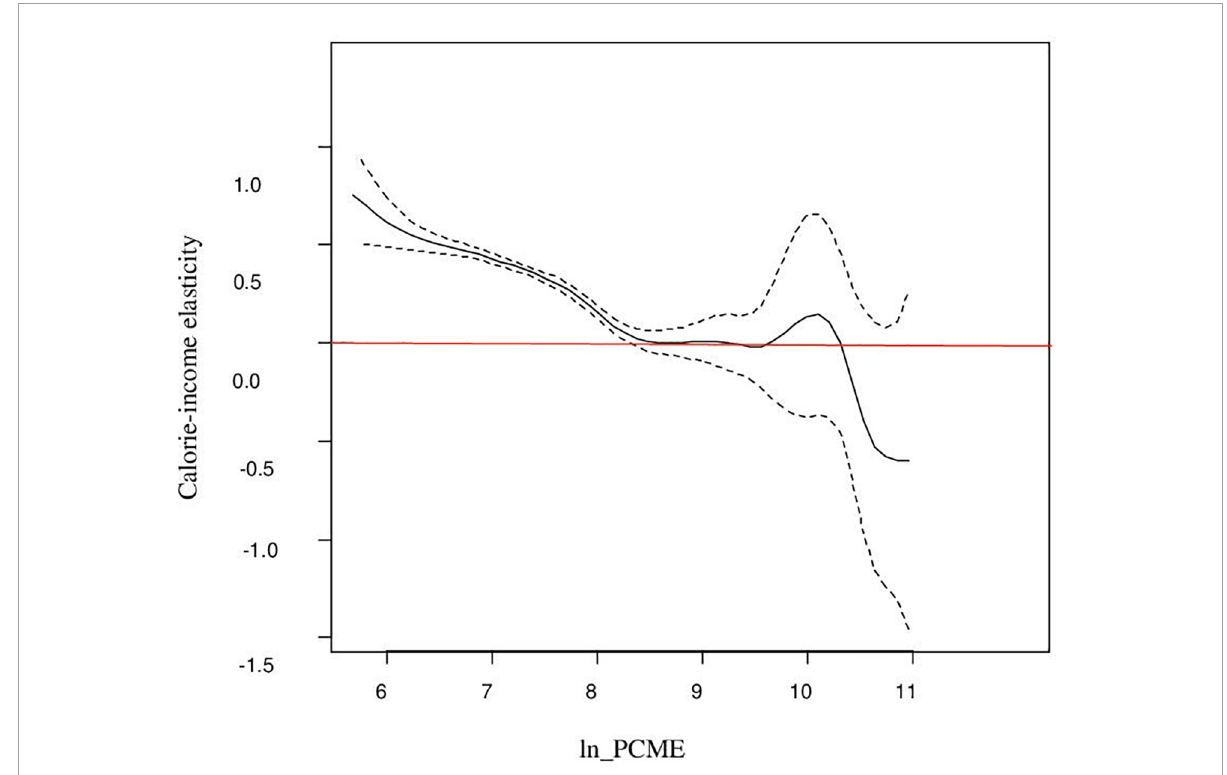
FIGURE2 Semi-parametric partially linear estimation of calorie–income